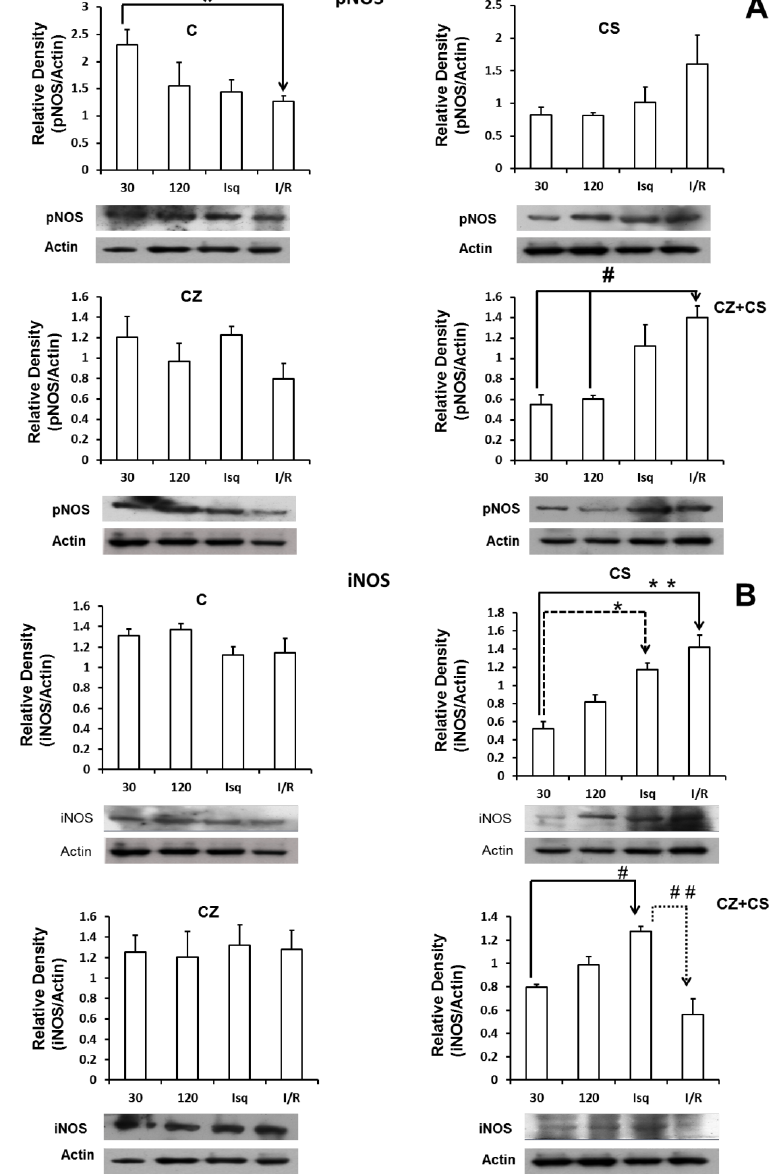
Figure 6. pNOS (A) and iNOS (B) expression in isolated hearts of rats treated with CS, CZ and CZ+CS under conditions of perfusion (30 and 120 min), ischemia (30 min) and reperfusion (60 min). Values are the mean ± SE ( n = 5 in each group p ≤ 0.05). ( A ) * C 30min vs. I/R; # CZ+CS (30min vs. I/R). ( B ) * CS (30min vs. Is); ** CS (30min vs. I/R); # CZ+CS (30 min vs. Is); ## CZ+CS (Is vs. I/R ).